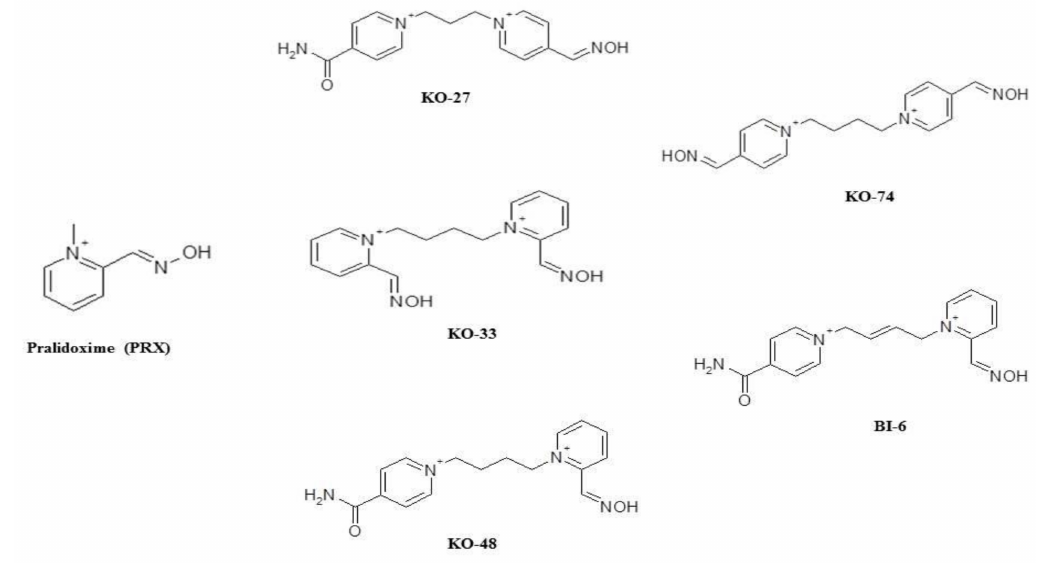
Figure 1. Chemical structure of pralidoxime (PRX) and new bisquaternary symmetric (KO-33, KO-74) or asymmetric pyridinium (KO-27, KO-48, BI-6)